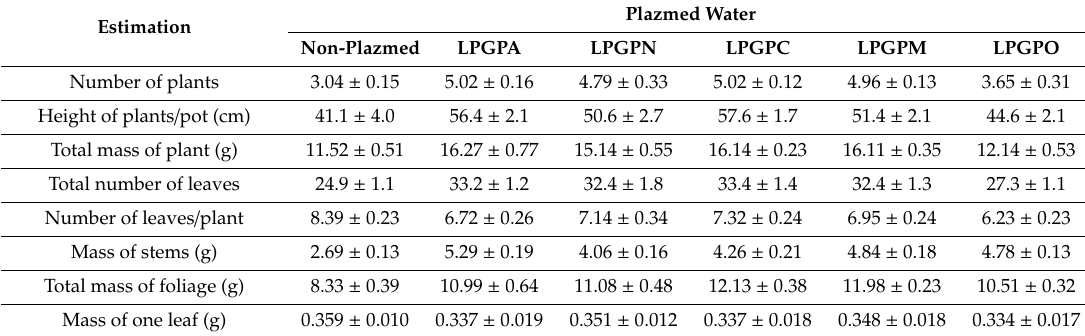
Table 1. Quantitative characteristics of the basil crops a